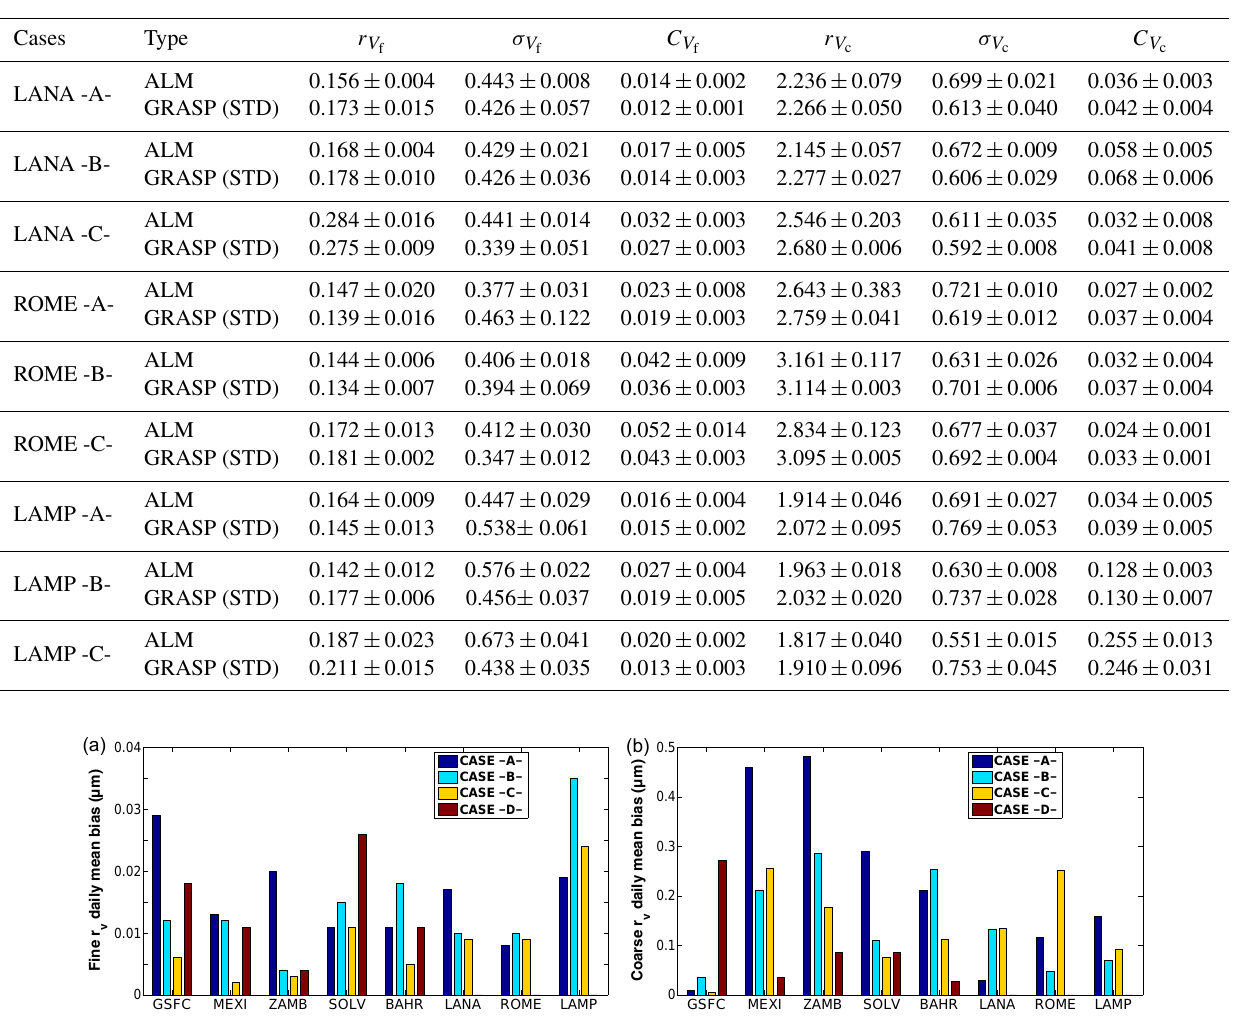
Figure 10. Absolute differences between the daily averages of the median volume radii retrieved by GRASP-AOD and AERONET standard inversions (total values can be found in Table 14) for the examples considered in the analysis as listed in Table 13. The differences for the fine mode are represented in the left panel and for the coarse mode in the right panel. Different days (A, B, C and possibly D) considered at each station and plotted with different